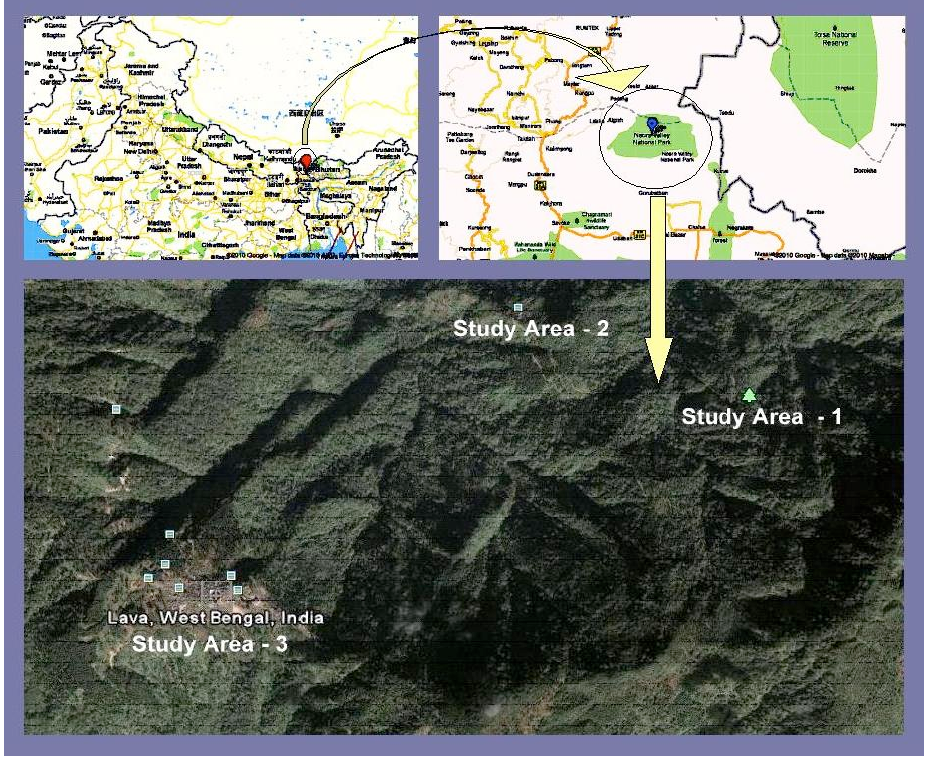
Image 1. Map of the three study areas in and around Neora Valley National